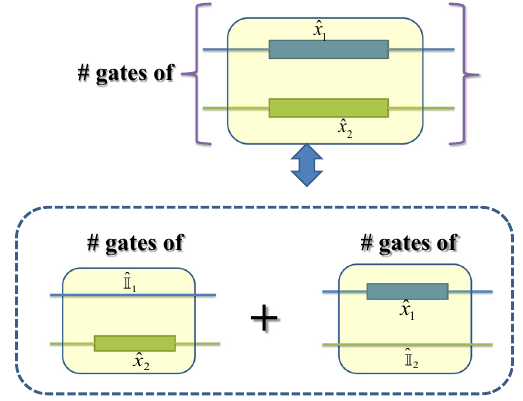
Fig. 2 Schematic diagram for the complexity of the Cartesian prod- uct and parallel decomposition rule. As two operators ˆ x 1 and ˆ x 2 are simulated independently, the minimally required gates for ( ˆ x 1 , ˆ x 2 ) is the sum of the minimally required gates for ˆ x 1 and ˆ x 2 . Thus, we have , ˆ x )) = C (( ˆ x , ˆ I )) + C (( ˆ I , ˆ x C (( ˆ x 1 2 1 2 1 2